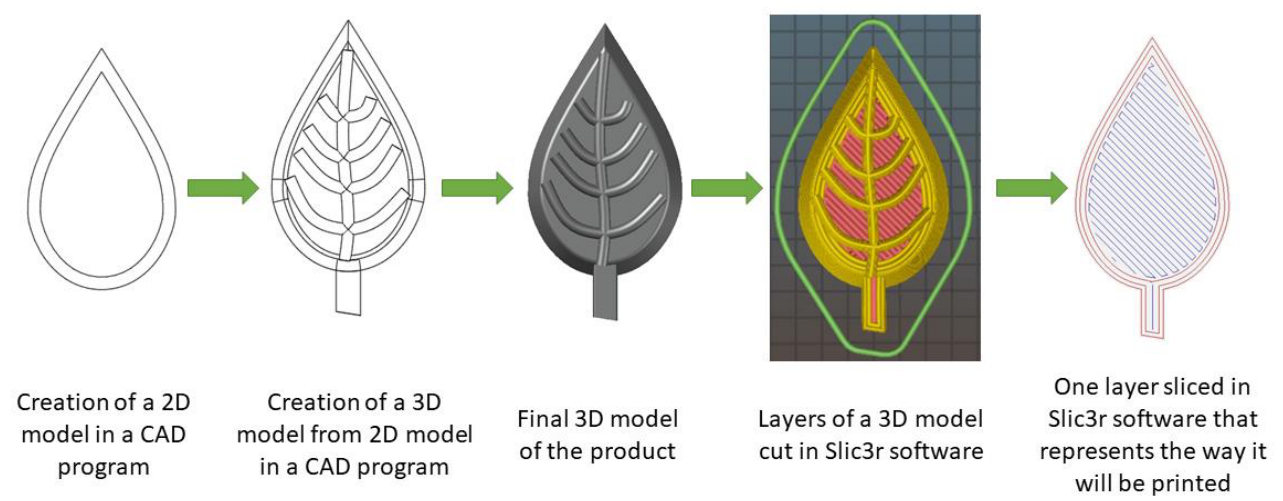
Figure 2. Process of product shape formation using additive manufacturing.